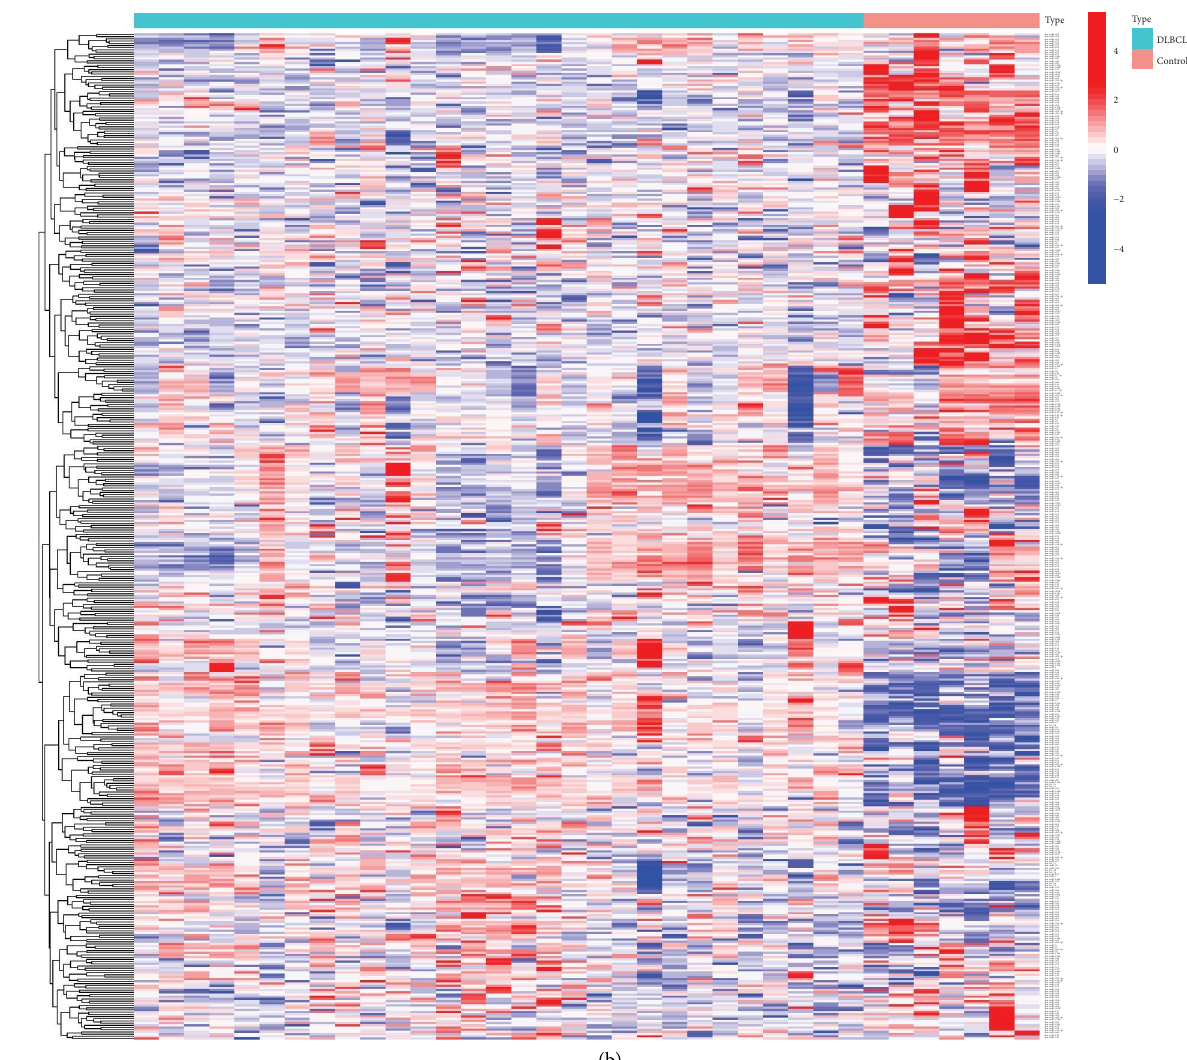
Figure 3: Heatmaps of signifcantly expressed miRNAs in GEO datasets. (a) 76 miRNA expression profles in GSE117063. (b) 457 miRNA expression profles in GSE29493.